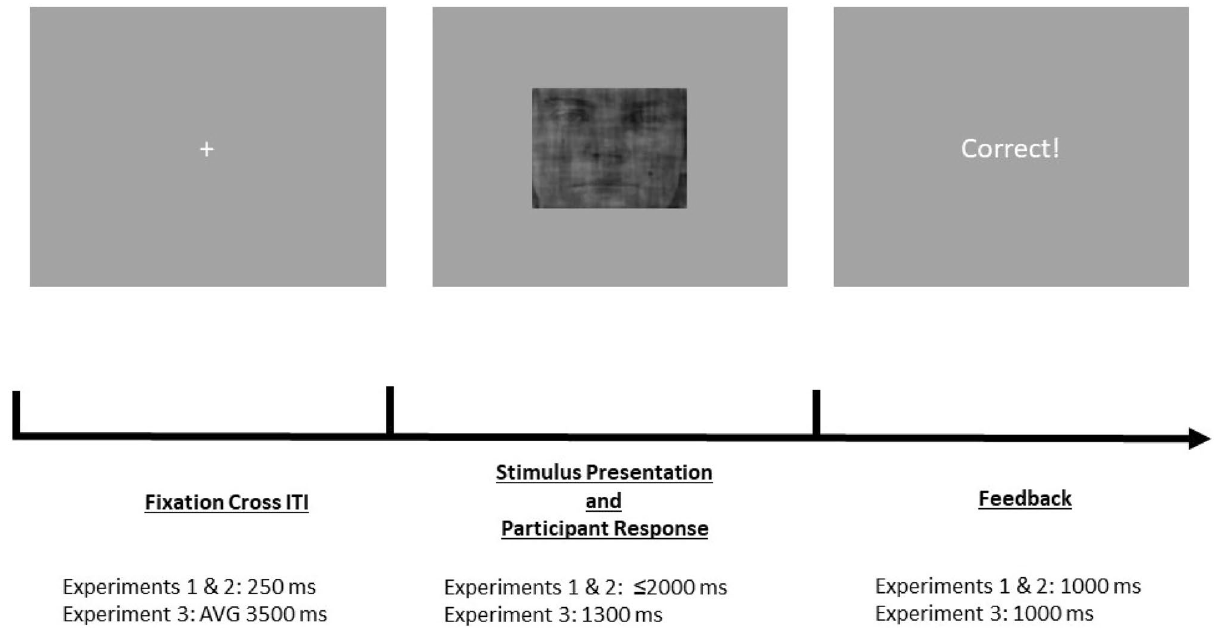
Figure 2. Experimental procedure for the face-house object discrimination task. Example trial of the face- house object discrimination task. We also list the parameters for all three experiments. Participants were shown a fixation cross during the intertrial interval (ITI). In experiments 1 and 2, the ITI lasted a fixed 250 ms. In experiment 3, it lasted an average of 3500 ms, jittered from 1000 to 9000 ms. Following the ITI, participants were shown the stimulus and were instructed to respond whether it more closely resembled a face or a house. In experiments 1 and 2, they were given 2000 ms to respond. Once a response was made, they would move on to the feedback screen. In experiment 3, participants were given 1300 ms to respond. Once a response was made, they remained on the stimulus screen until the 1300 ms had elapsed, at which point they moved on to the feedback screen. The feedback screen was presented for 1000 ms in all three experiments. On the feedback screen, participants were shown either “Correct!” or “Incorrect!” based on whether their response matched the objectively correct